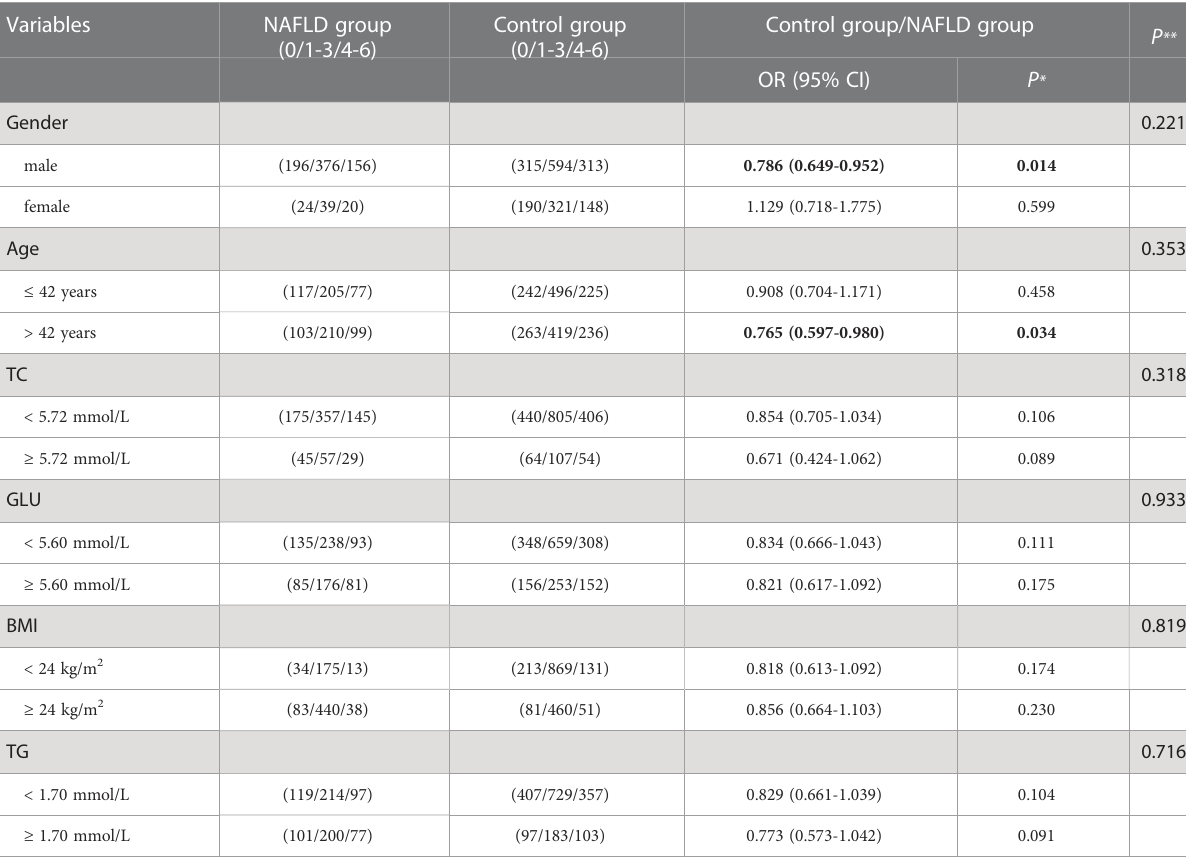
TABLE 4 Strati fi ed analysis of the association of the combined effects of HSPA5 -rs12009, HSPA5 -rs430397, and ITPR2 -rs11048570 with NAFLD risk. Variables